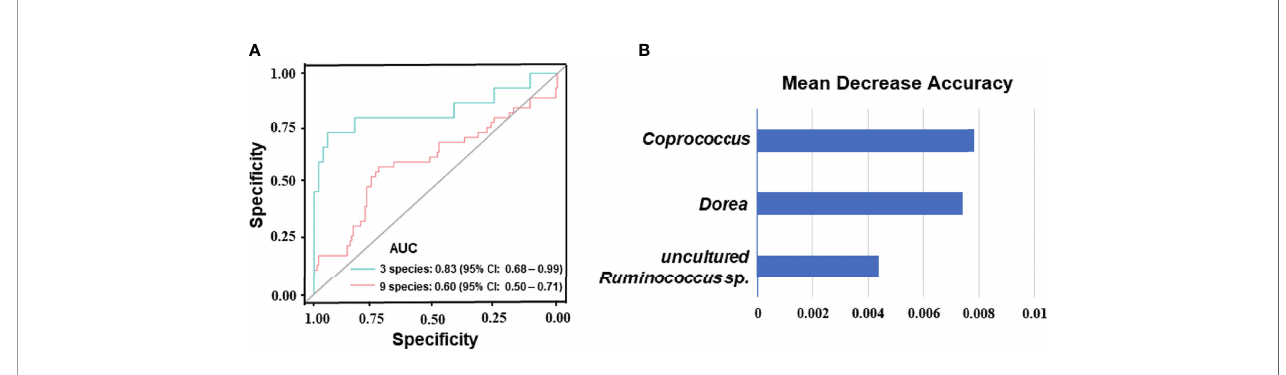
FIGURE 4 | Disease classi fi cation based on gut microbiome signature. (A) Classi fi cation performance of the random forest model using the relative abundance of NAC- ef fi cacy associated genera was assessed by the area under the ROC in BC patients. The combination of 3 signature bacteria: Coprococcus, Dorea , and uncultured Ruminococcus sp. The combination of 9 optimal species markers: Bacteroides, Coprococcus, Dorea, Fusicatenibacter, Ruminococcus, Butyrivibrio sp. CAG 318 , Lactobacillus salivarius, Bacteroides xylanisolvens , and uncultured Ruminococcus sp. (B) Identi fi cation of the signature gut microbiota associated with NAC- ef fi cacy by random forest. Fivefold cross-validation together with random forest was performed to determine the signature biomarkers. Detailed signature biomarkers ’ random seed from the random forest is presented between the NAC non-effectual group and the NAC effectual